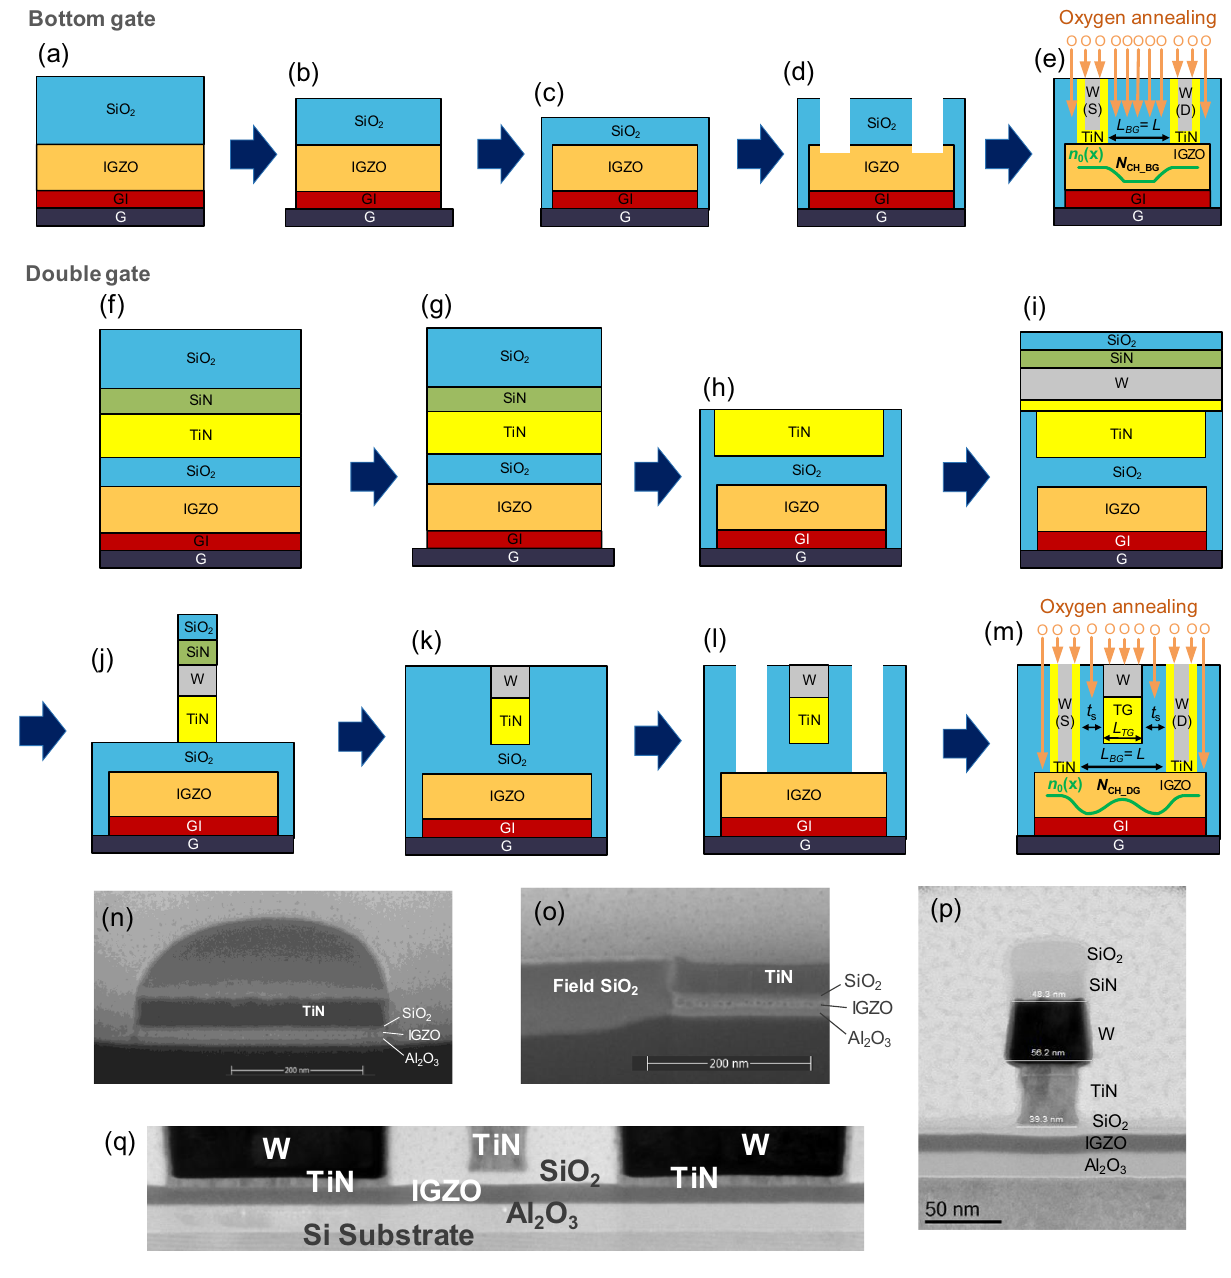
Figure 1. The integration process of the IGZO FET fabrication. Process sequence for ( a – e ) BG and ( f – m ) DG FET fabrication. SEM images of DG FET ( n ) after active patterning ( g ) and ( o ) after planarization ( h ). TEM images of DG FET ( p ) after gate patterning ( j ) and ( q ) after metallization ( m